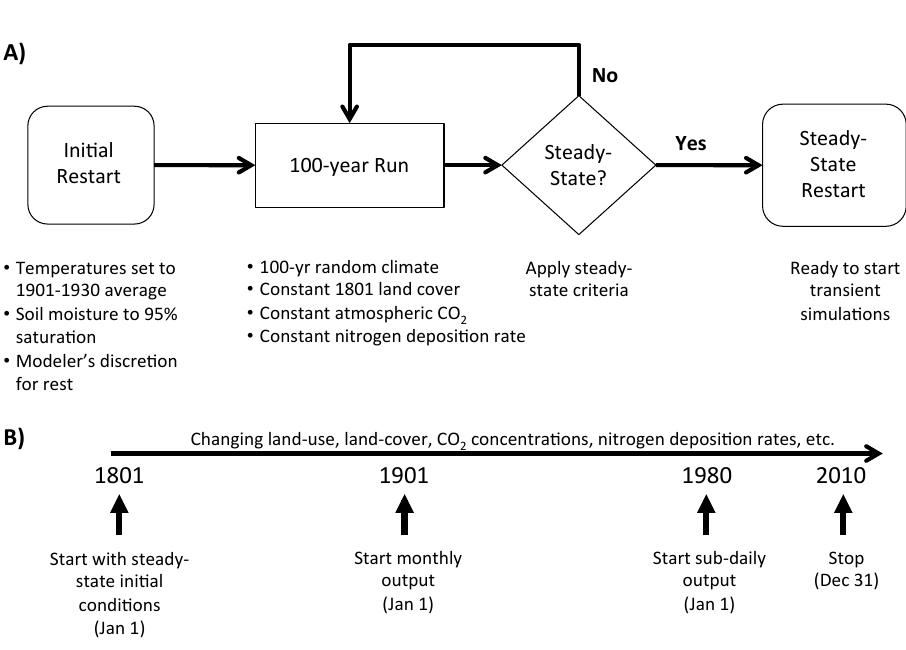
Fig. 4. Schematic of (A) the spin-up procedure to steady state; and (B) the basic timeline for each MsTMIP simulation starting from steady- state conditions reached in (A) . All transient simulations (B) run from 1801 through 2010 (210yr). The same initial conditions are used for both the global and North American